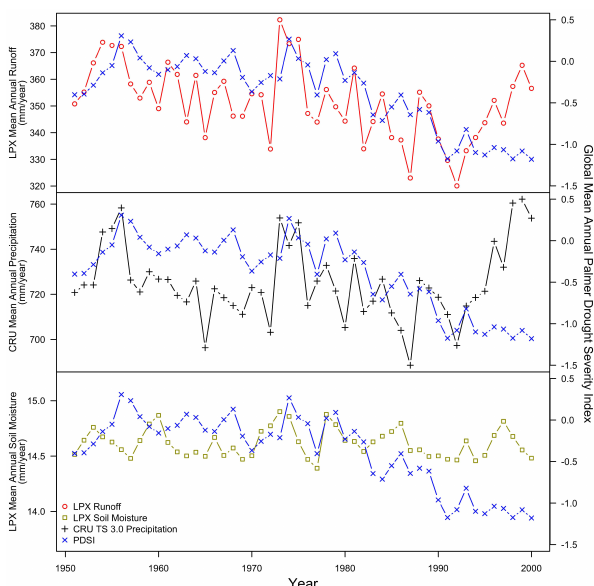
Fig. 10. Global mean annual Palmer Drought Severity Index (PDSI) versus LPX global mean annual runoff and soil moisture (from both soil layers) and CRU global mean